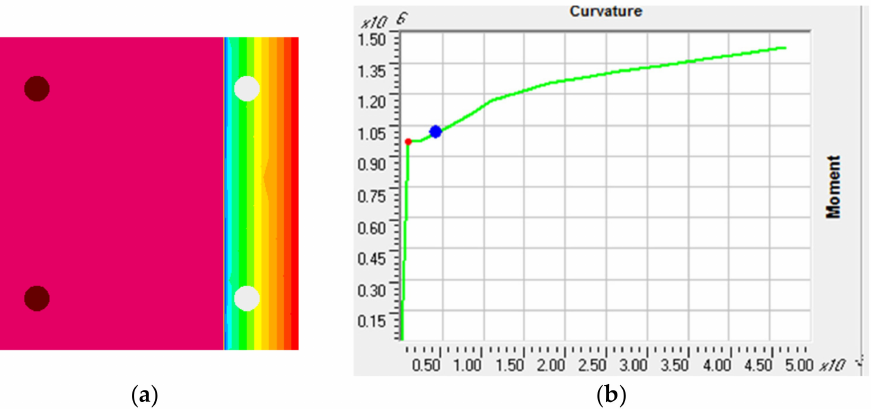
Figure 2. ( a ) Fiber-based sectional analysis ( b ) Moment–curvature diagram evaluated by